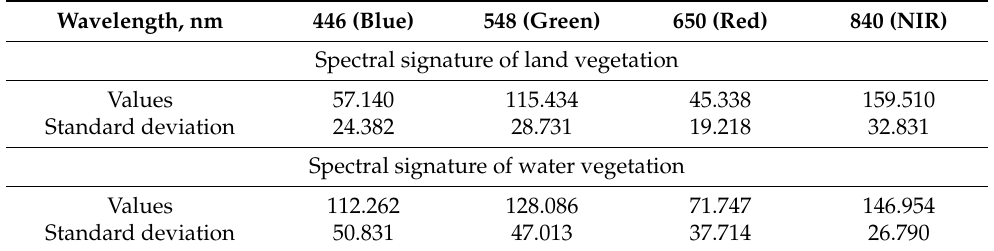
Table 3. Statistical analysis of the spectral reflectance of land and water